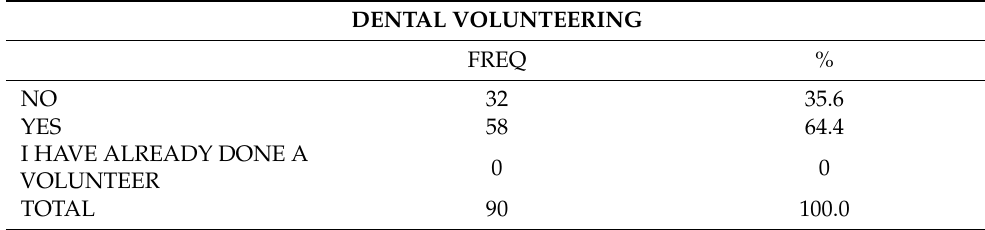
Table 4. answers about dental